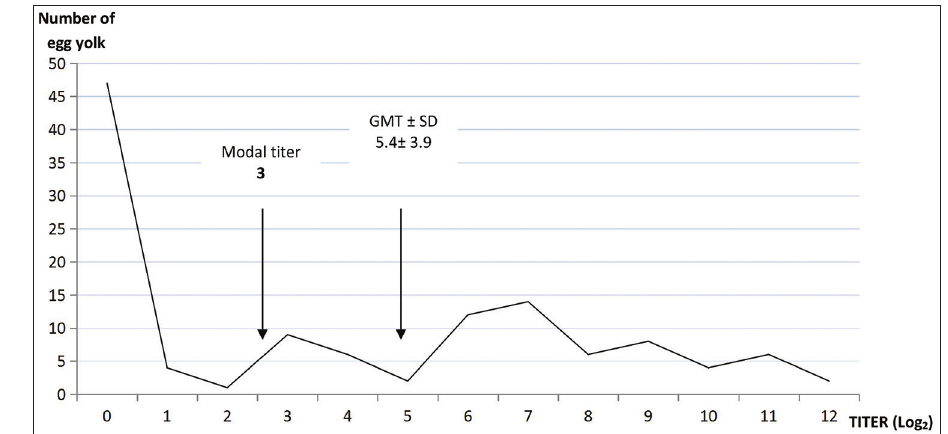
Figure-4: Newcastle disease virus hemagglutination inhibition titer of chloroform extracted egg yolk of local